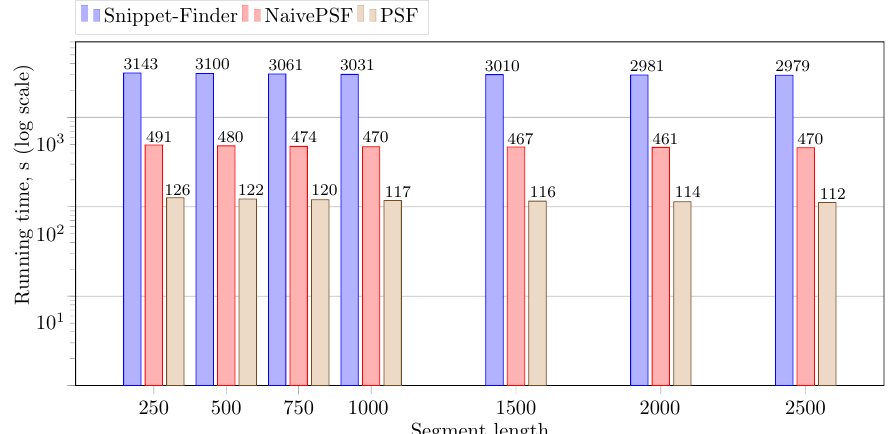
Figure 8. Performance of the PSF algorithm depending on the segment length.